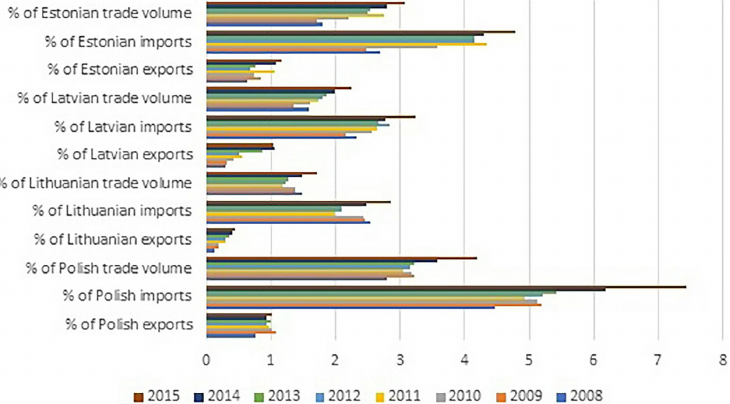
Fig. 1. China’s share of the Polish, Lithuanian, Latvian and Estonian exports, imports and the trade volume Source : own calculation based on IMF (2011, 2015,